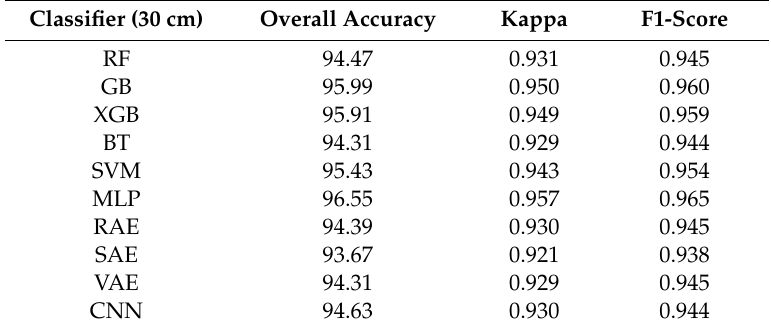
Table 2. Accuracy measures derived from the models applied on the 30 cm